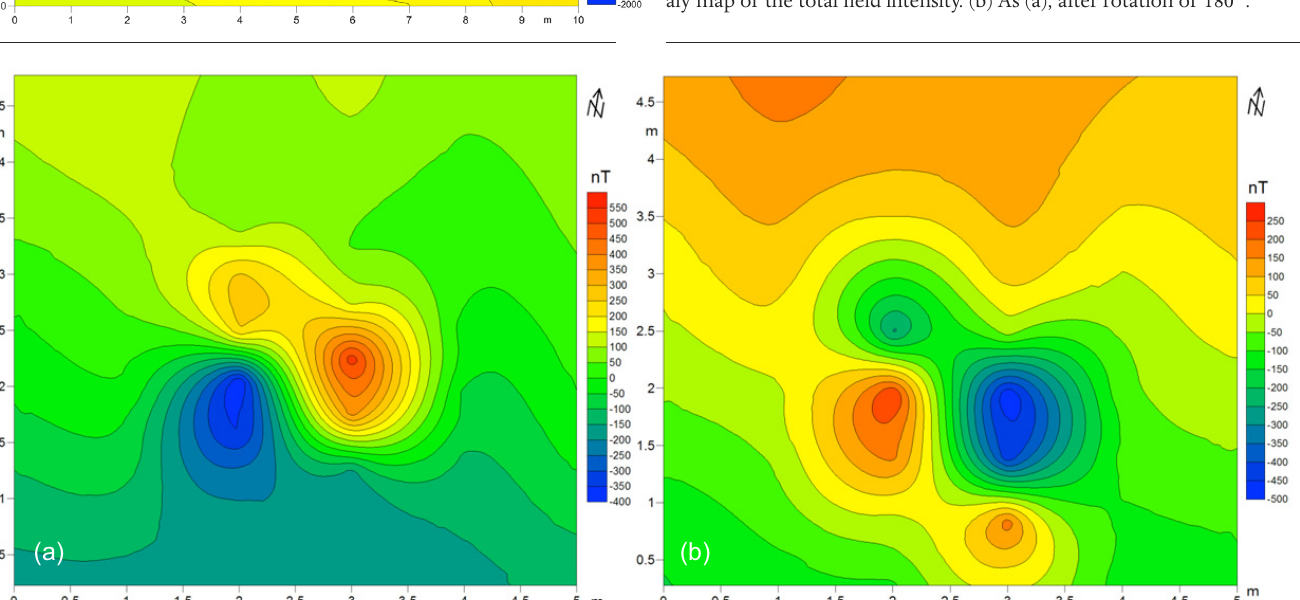
Figure 7 (below, left to right). A drum lid on the ground surface. (a) Anom- aly map of the total field intensity. (b) As (a), after rotation of